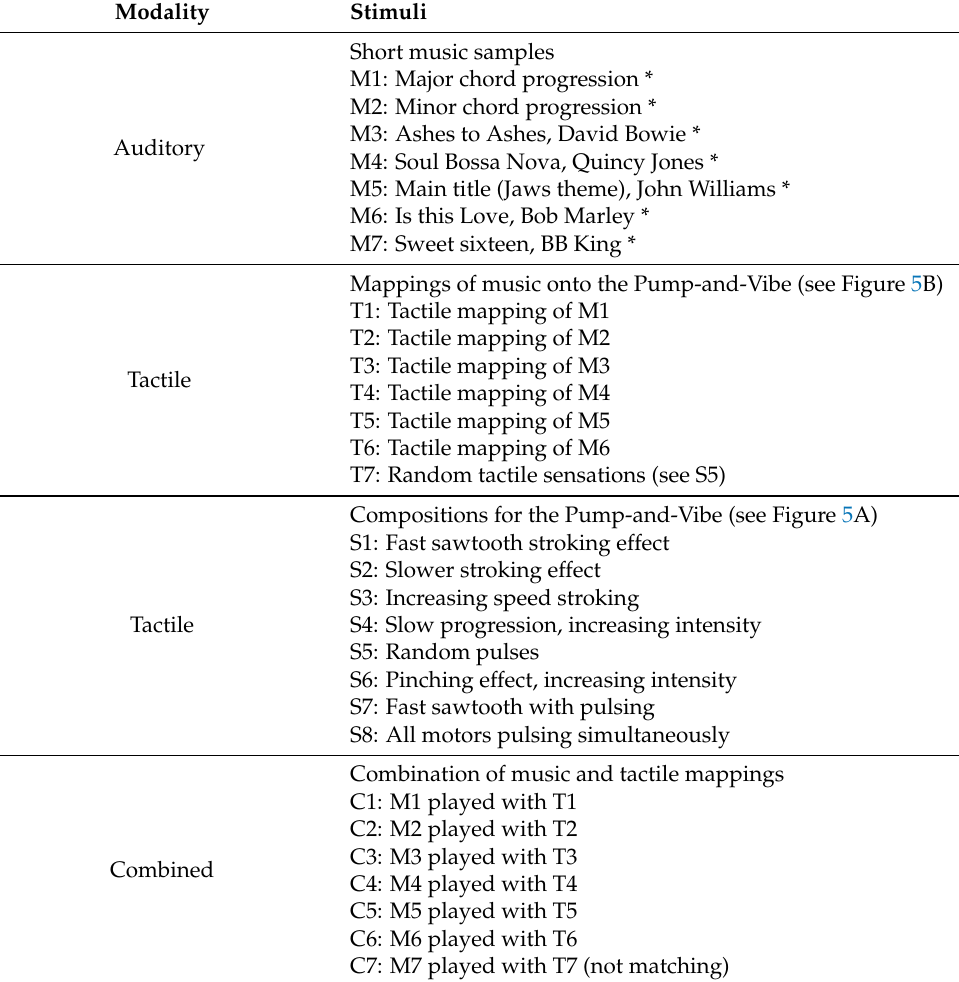
Table 1. The list of stimuli presented to participants. Stimuli were randomised per participant, but combined stimuli were presented last so as not to bias the responses to the separate music and tactile